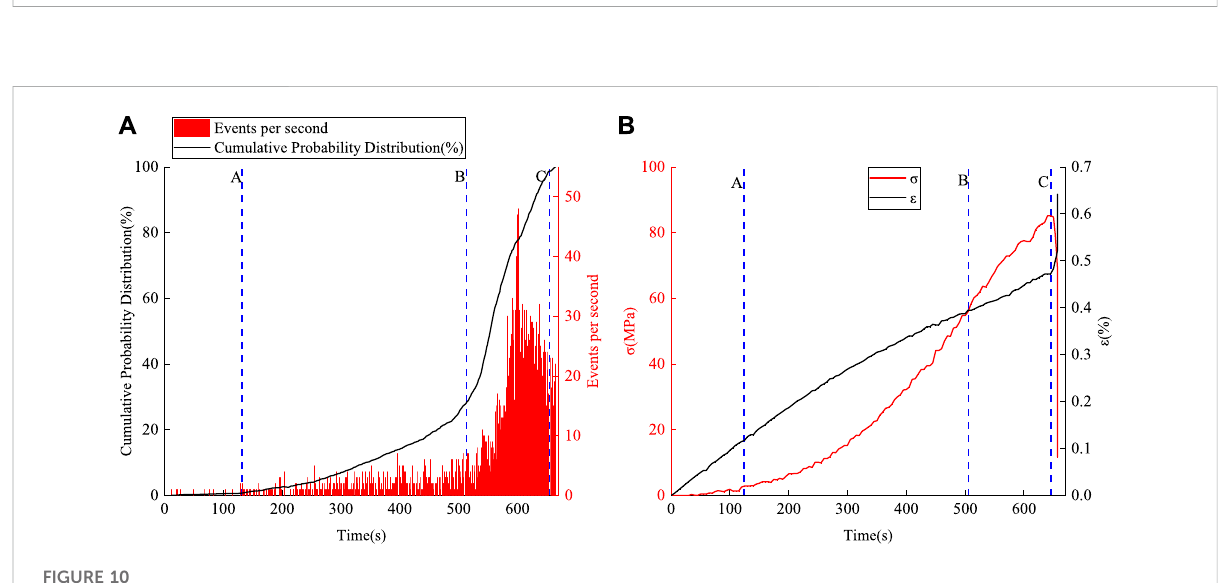
FIGURE 10 Results obtained for specimen G3: (A) CPD of the feature events and (B) variation of the stress and strain in the specimen during the same